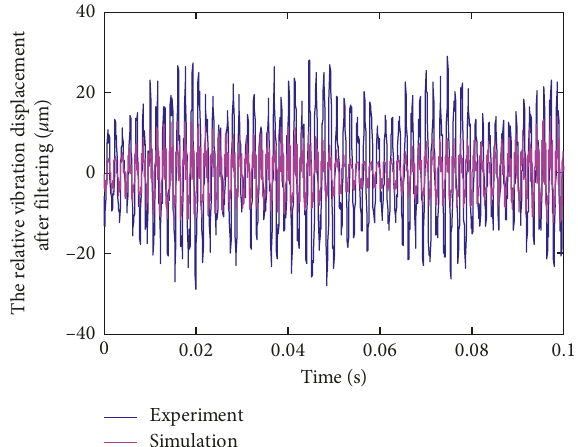
Figure 24: Mesh frequency component of dynamic transmission error.